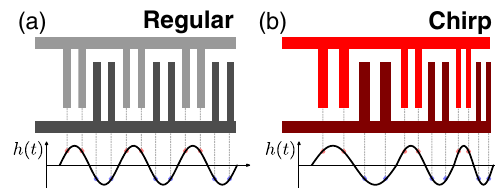
FIG. 10. Construction of the impulse response of IDTs. We show examples of the response function h ð t Þ (vertical axis) in comparison to the finger positions for (a) a regular IDT and (b) a chirp IDT.